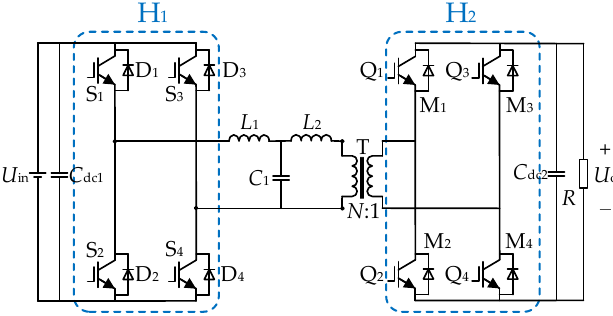
Figure 1. Topology of the LCL-DAB DC-DC converters.